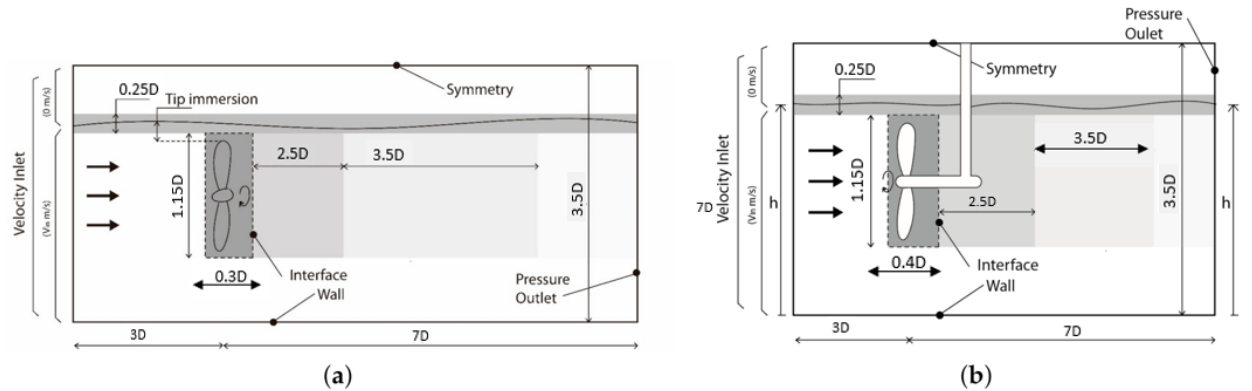
Figure 2. Computational domain and boundary conditions considering ( a ) the rotor only and ( b ) the full turbine. Shaded areas represent mesh refinement